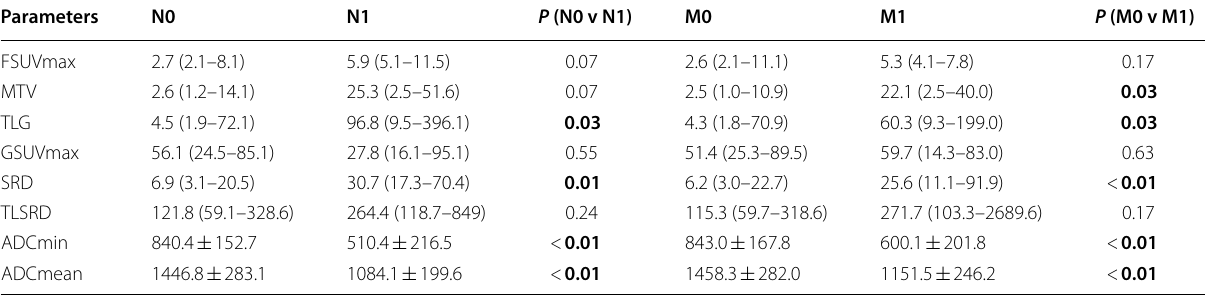
Table 3 Parameters of 68 Ga-DOTATATE and 18 F-FDG dual tracer PET/MR based on N stage and M